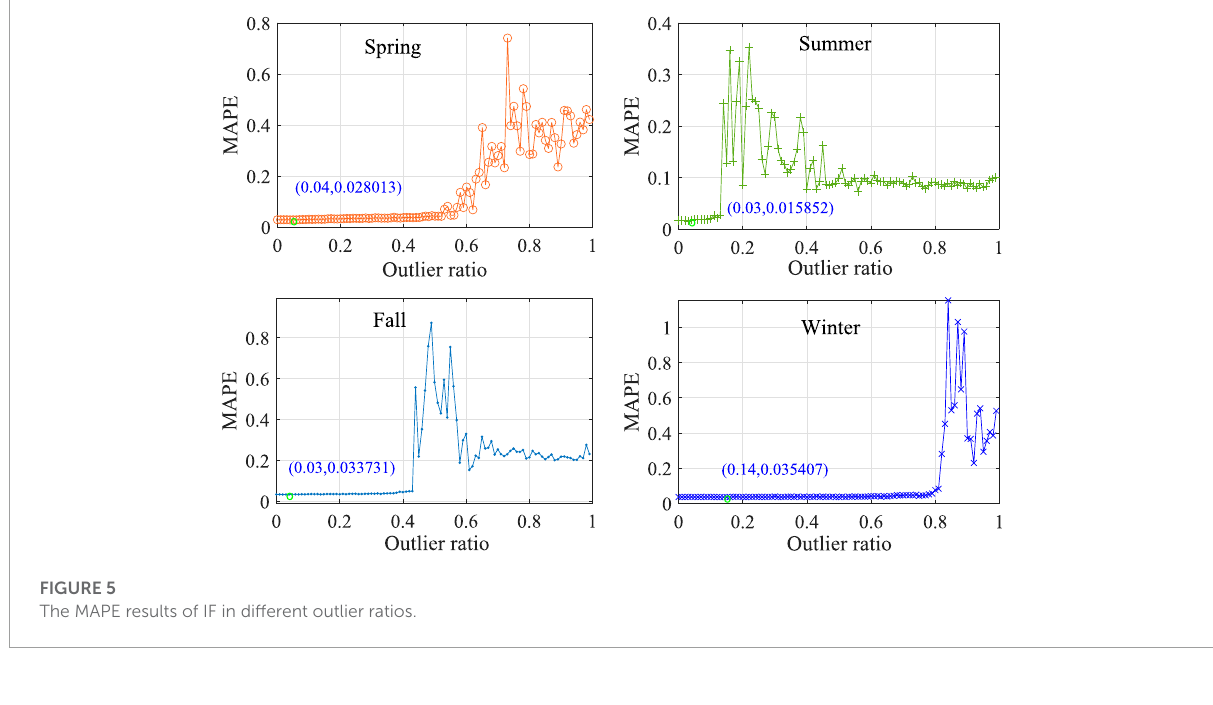
FIGURE 5 The MAPE results of IF in different outlier ratios.